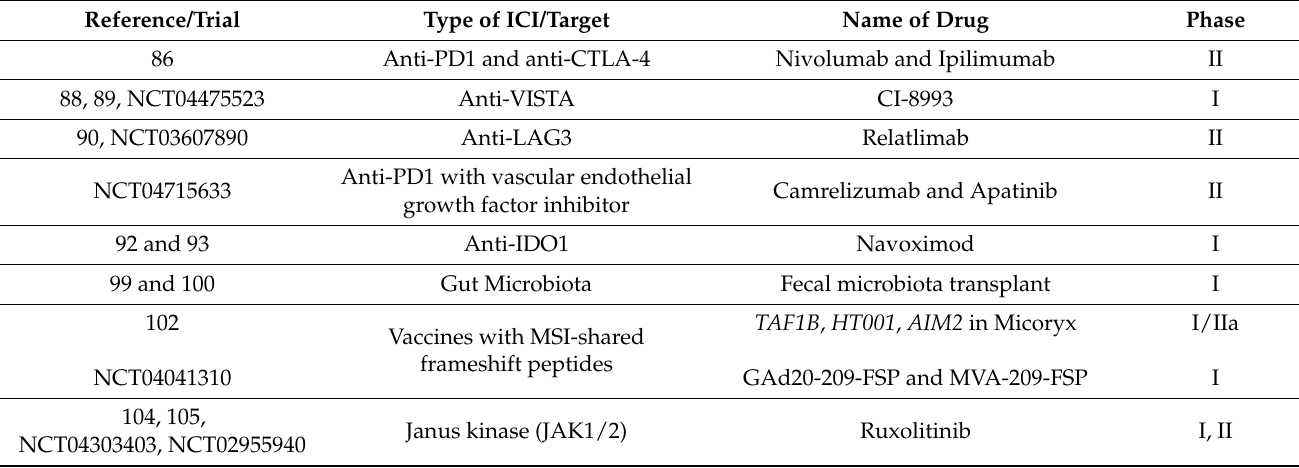
Table 1. Therapeutic development to overcome resistance to immune checkpoint inhibitors in dMMR/MSI CRCs.